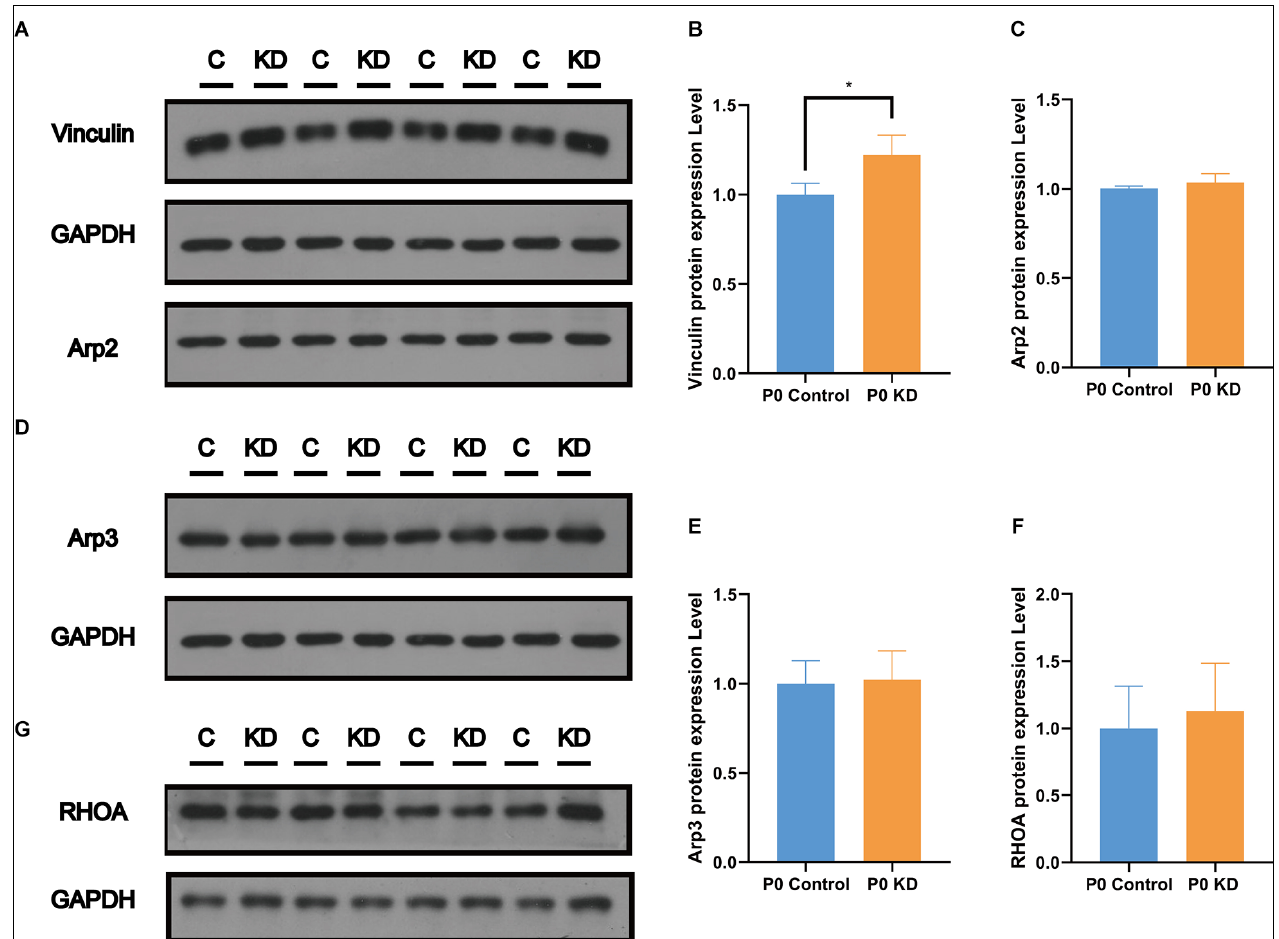
FIGURE 7 | Significant increase of Vinculin was observed in the P0 KD group at P6. Protein expression level of Vinculin, Arp2 (A) , Arp3 (D) , and RHOA (G) in P0 control and P0 KD groups. Comparison of Vinculin (B) , Arp2 (C) , Arp3 (E) , and RHOA (F) by western blot in P0 control and P0 KD groups. The differences of Arp2, Arp3, and RHOA expression level between the P0 KD and the P0 control group were not significant ( P > 0.05). *Significantly different from the control group ( P <